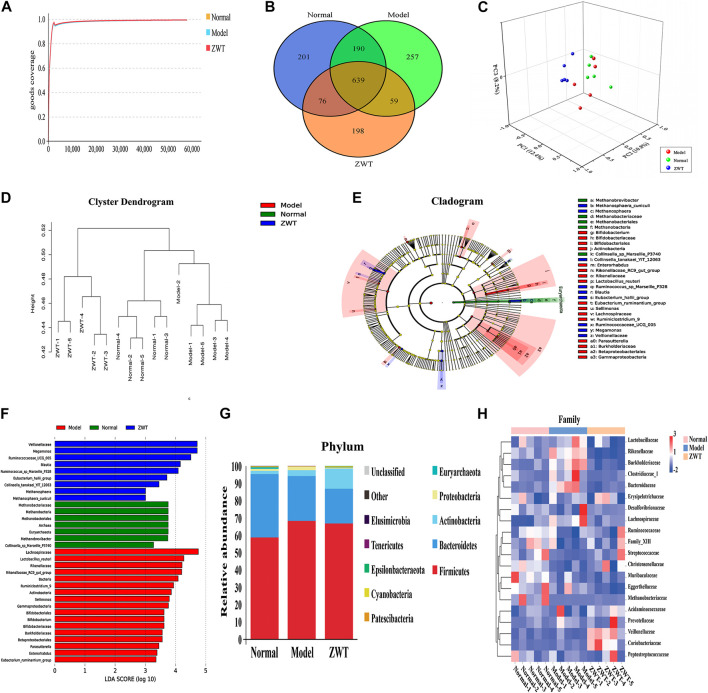
Effect of ZWT on gut microbiota of IgAN rats. (A) Shannon rarefaction curves of normal, model, and ZWT groups. (B) Hierarchical clustering analysis of UPGMA in three groups based on unweighted UniFrac analysis. (C) 3D-PCA was executed in the three groups, based on OTU levels. (D) Venn diagram showing observed OTU numbers among the three groups. Orange symbols indicate ZWT group; blue symbols, normal group; and green symbols, model group. (E) Phylogenetic tree in cladogram format displaying discriminatory bacterial taxa among the three groups, based on LEfSe analysis (phylum to genus level). (F) The difference in abundance levels of bacterial taxa among the three groups (LDA score > 3.0, Wilcoxon rank-sum test p < 0.05). (G) Stacking diagram of species distribution between normal, model, and ZWT groups at the phylum level from fecal 16S rDNA sequencing data (top 10). (H) Heatmap showing the component proportion of microbiota of each sample from the normal, model and ZWT groups at the family level (top 20).